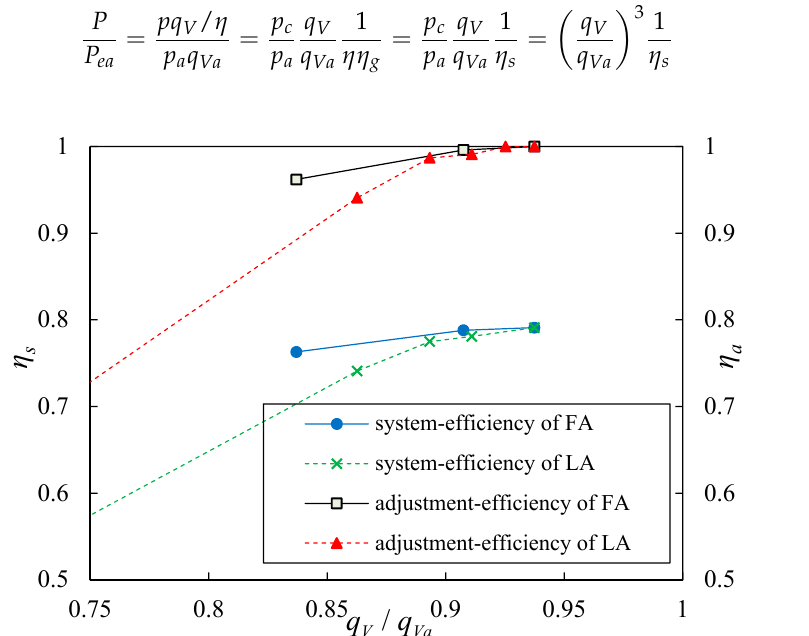
Figure 9. The economic performance curve of different adjustments based on the experiment. Figure 9 indicates the system-efficiency and adjustment-efficiency curves on the LA and FA